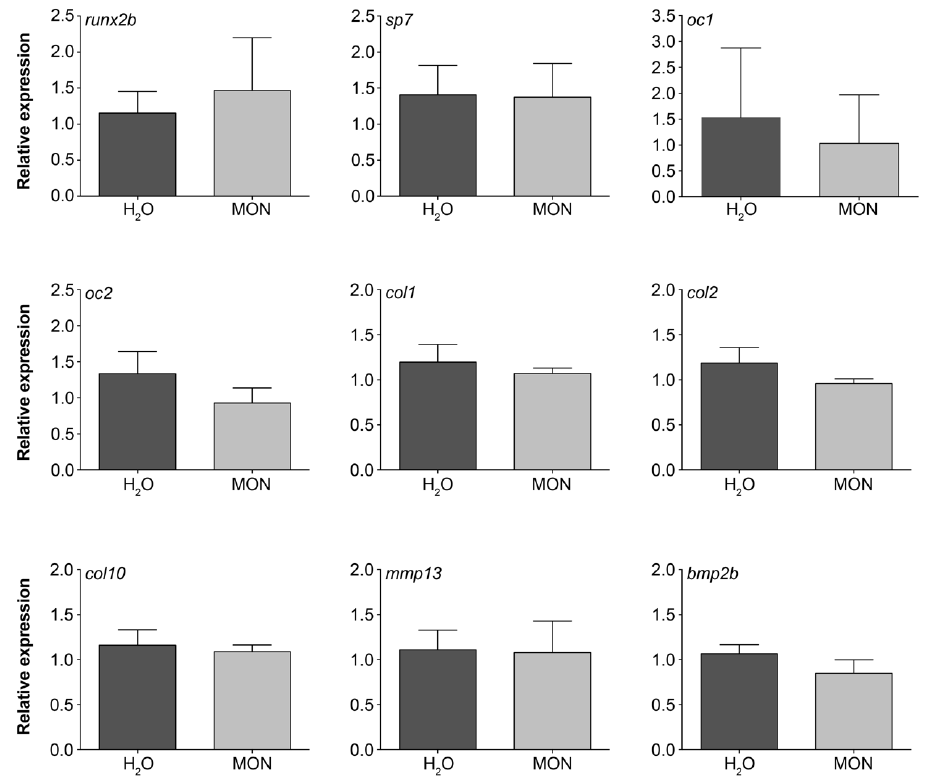
Figure 4. Effects of MON on mRNA expression of selected genes. Zebrafish larvae were treated from 3 to 9 dpf with MON (900 µg L −1 ). The averaged expression of eef1a1l1 , actb1 and rps18 mRNAs was used as a reference to normalize the expression levels of the studied genes. Data presented as average ± SD of